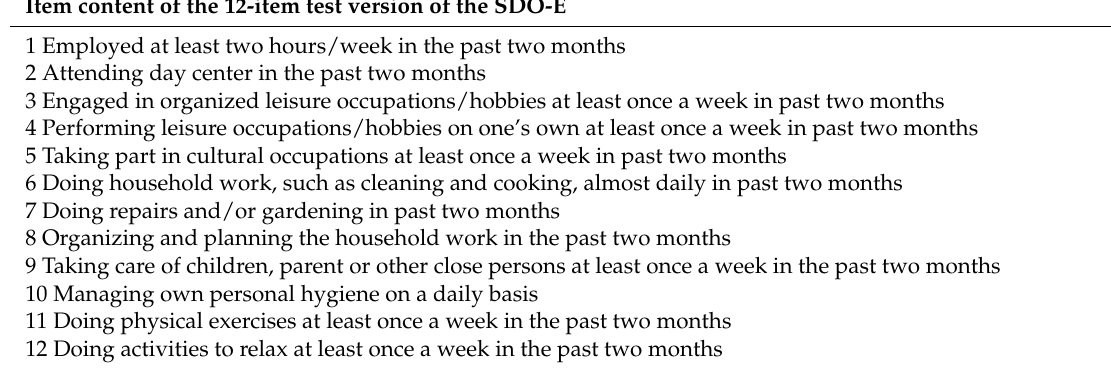
Table 1. Item content of the 12-item test version of the